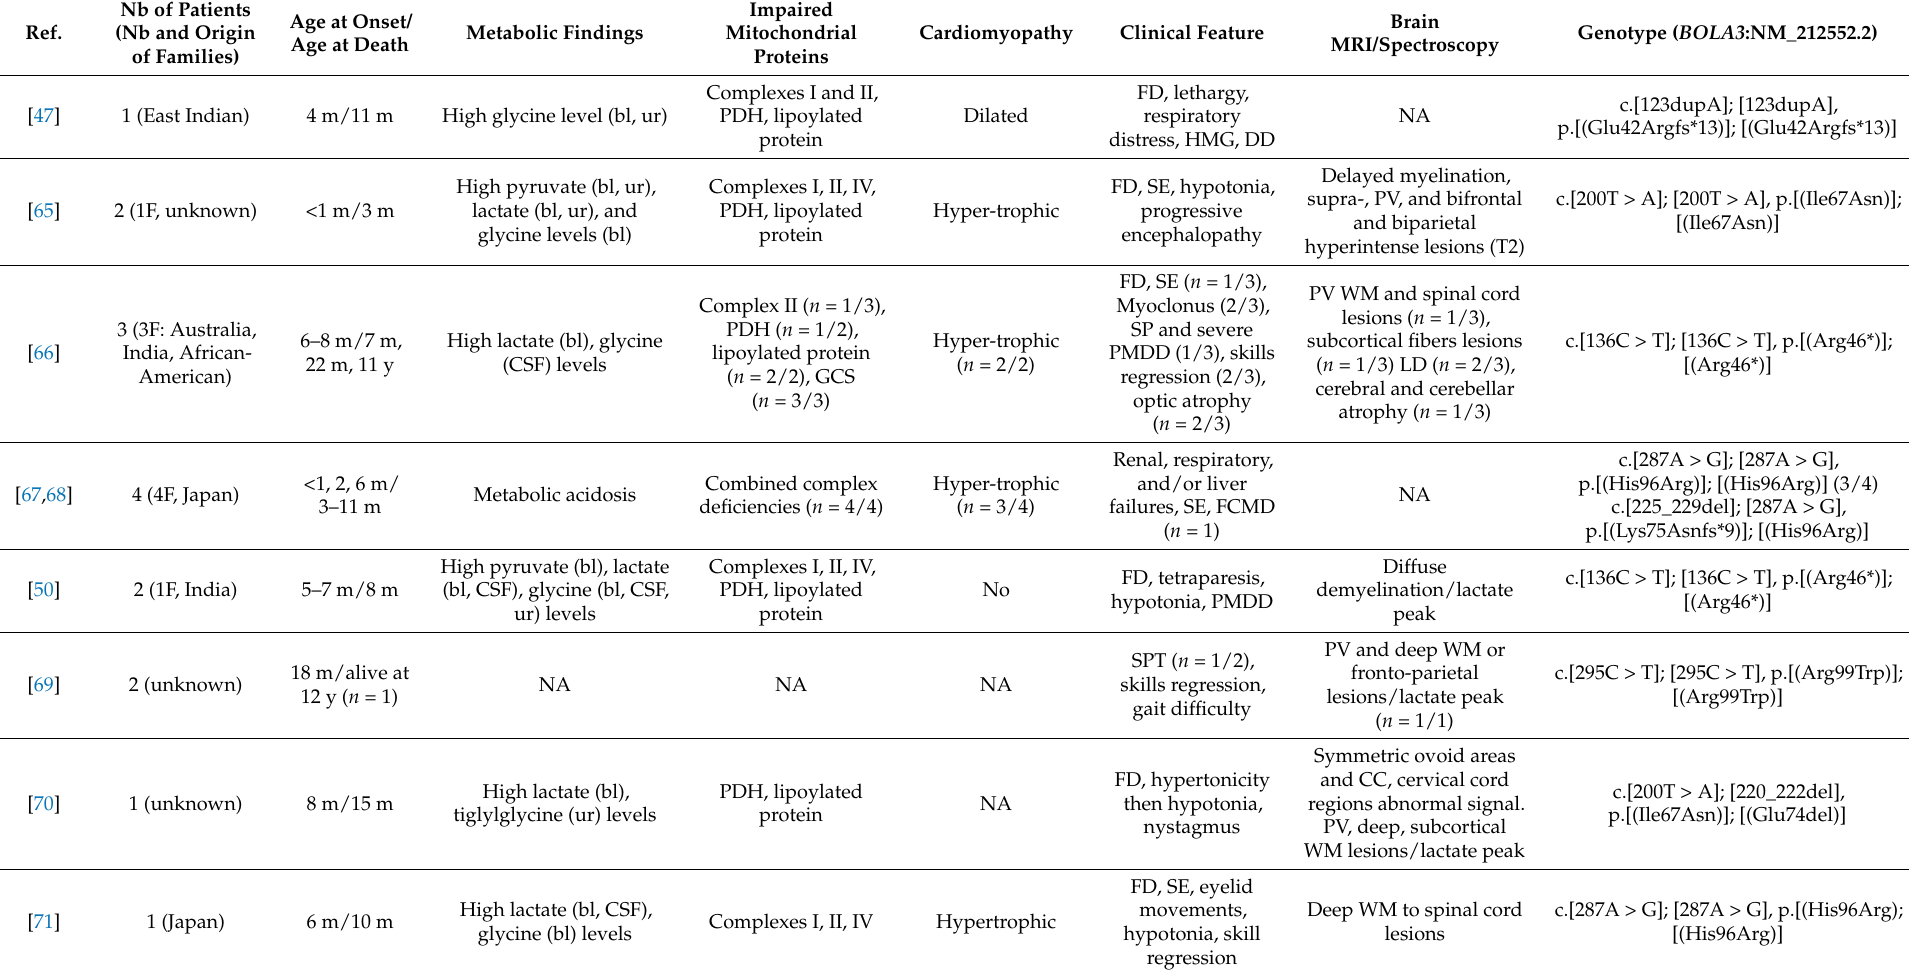
Table 2. Reported patients with MMDS type